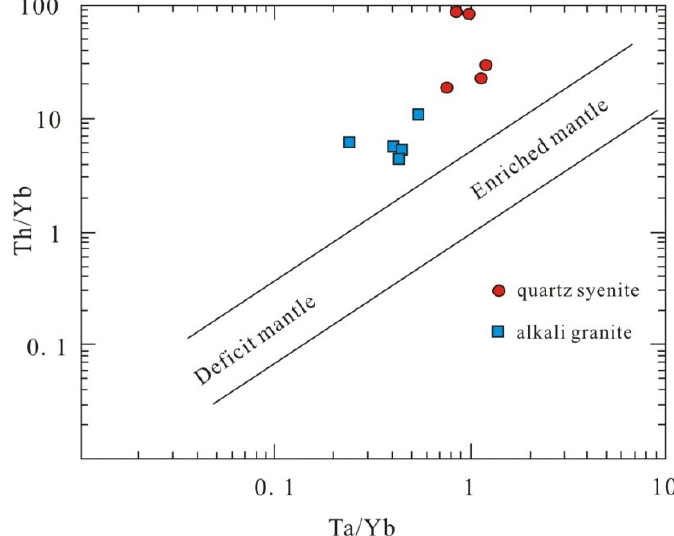
Figure 8. Ta/Yb–Th/Yb diagram of the Chishan alkaline complex. The diagram is from [62].